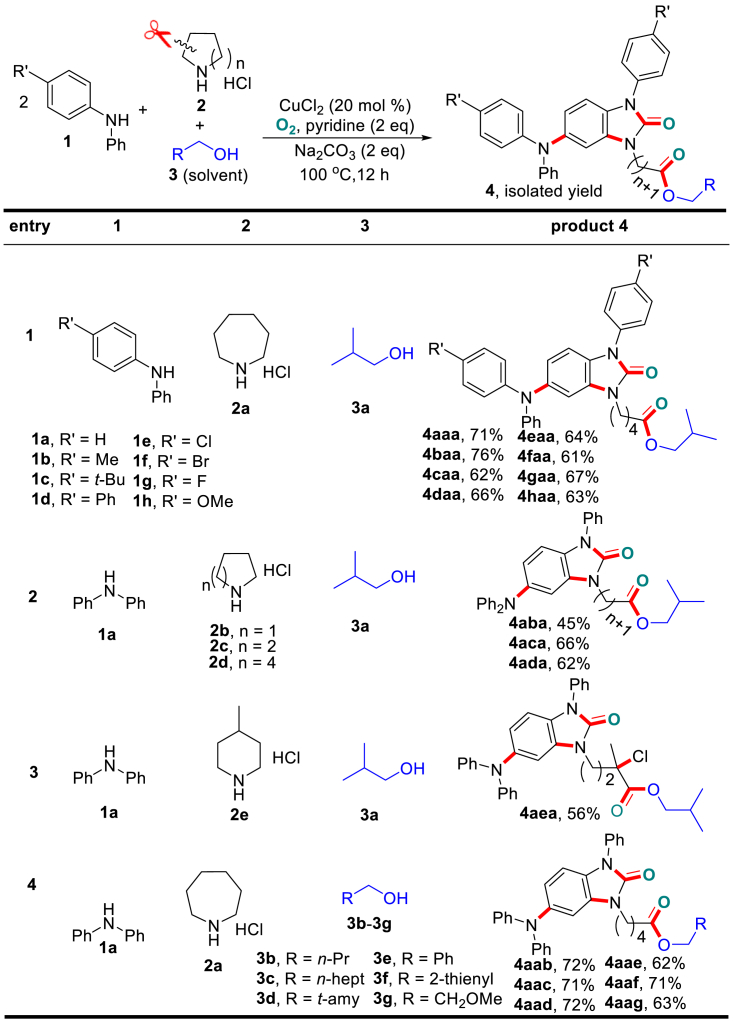
Variation of the Three Coupling PartnersAlso see Figures S1–S37.